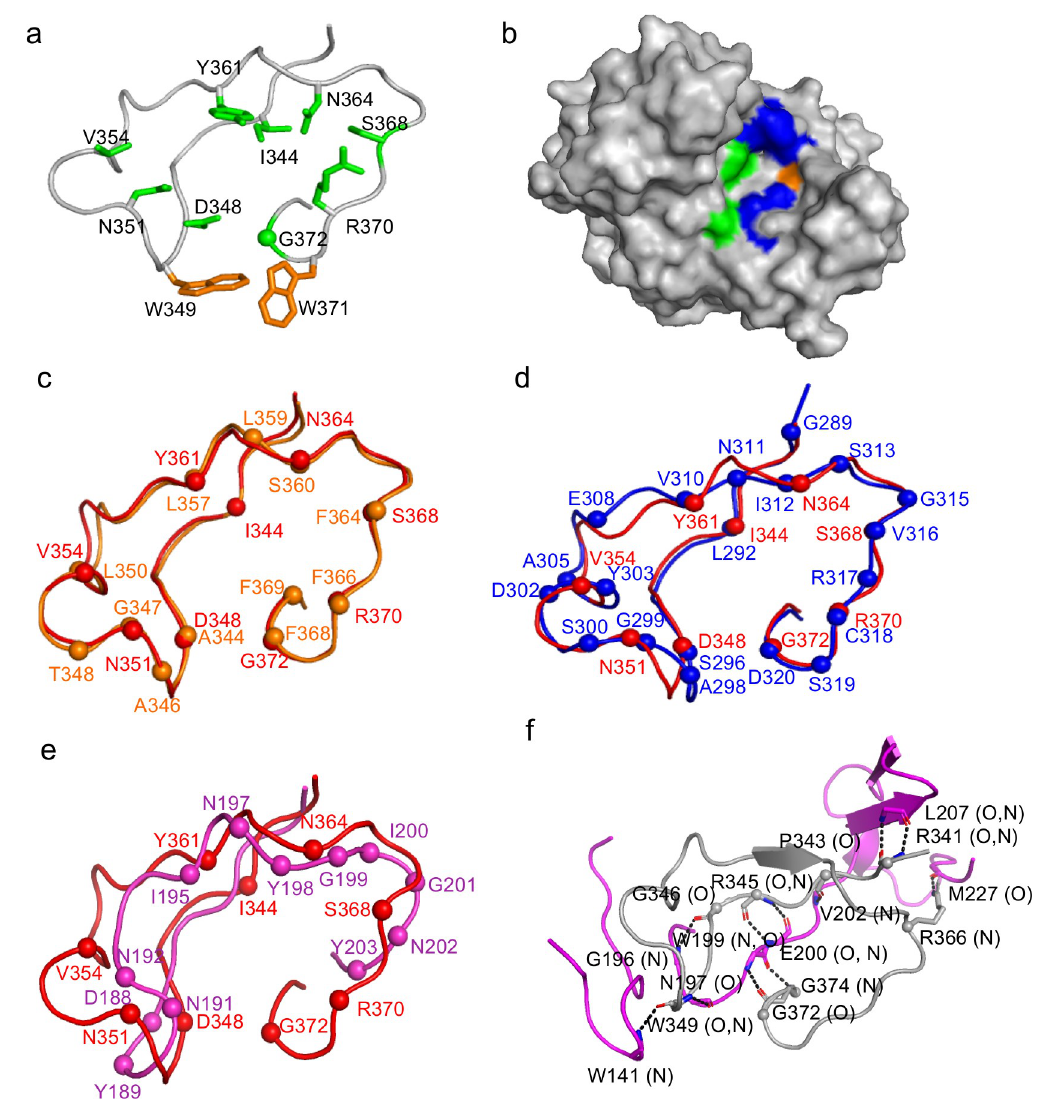
Fig 3. Variable region of TaqVP. a. VR of TaqVP in ribbon representation. The main chain is in gray, side chains of variable amino acids are in green (sphere is glycine), and nonvariable aromatic amino acids are in orange. b. Surface representation of TaqVP, with the VR facing the viewer. Variable hydrophobic amino acids (I, V, and Y) are green, variable hydrophilic amino acids (S, N, D, and R) blue, and variable glycine pale orange. c. Superposition of the VR of TaqVP (red) and Mtd-P1 (orange) in C α representation. The spheres represent the position of variable amino acids in each protein. d. Superposition of the VR of TaqVP (red) and TvpA (blue) in C α representation. e. Superposition of the VR of TaqVP (red) and AvpA (magenta) in C α representation. f. Stabilization of the main chain of VR (gray, C α of variable amino acids indicated by spheres) by insert 1’ (magenta) in C α representation. Dashed line indicates hydrogen bonds.